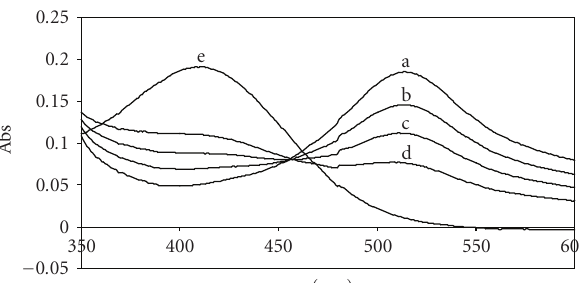
− 0 . Figure 3: UV spectra of DPPH/Rottlerin solutions in absolute ethanol. (a) 20 μ M DPPH ethanol solution (A); (b) spectrum of the mixture DPPH/Rottlerin obtained by mixing 2.5ml of solution A with 0.5 ml of solution B (10 : 1 molar ratio); (c) 2.0ml of solution A with 1ml of solution B (4 : 1 molar ratio); (d) 1.5 ml of solution A with 1.5 ml of solution B (2 : 1 molar ratio); (e) spectrum of 10 μ M Rottlerin ethanol solution (B).